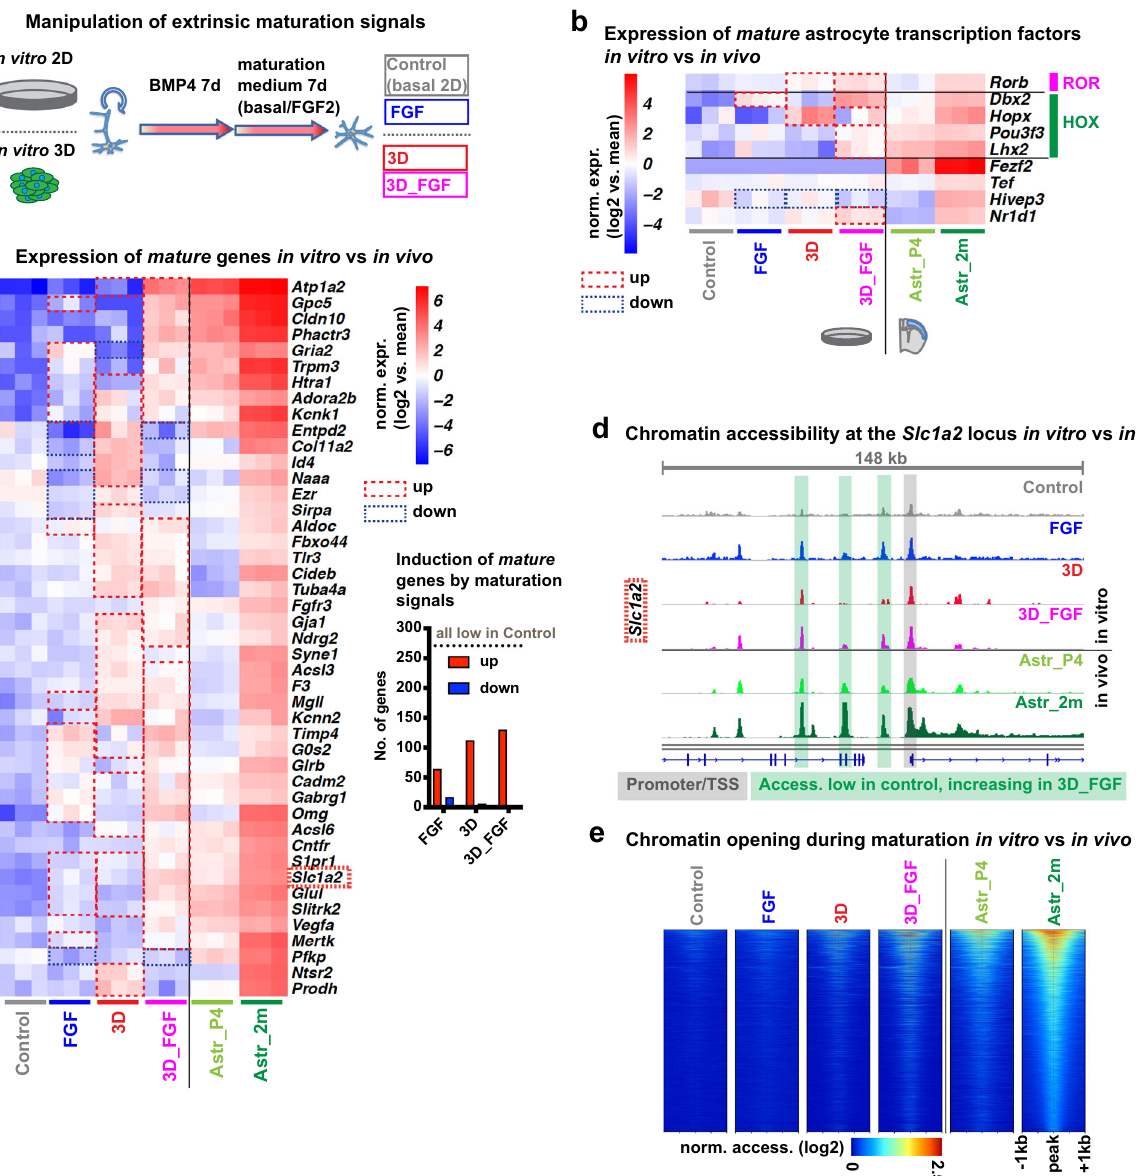
Fig. 7 Extrinsic signals promote the transcriptional and epigenetic maturation of astrocytes. a Experimental design to assess the effects of extrinsic signals on astrocyte maturation. Initial differentiation with BMP4 is followed by 7 days in different maturation conditions: control (basal medium in conventional two-dimensional cultures) ±FGF2 (control/FGF) or in three-dimensional gel-embedded cultures (3D/3D_FGF). b , c Expression of mature astrocyte-speci fi c transcription factors ( b ) and other genes ( c ) in cultured astrocytes and cortical astrocytes (at postnatal day 4 (Astr_P4), and 2 months of age (Astr_2m)). Heatmaps of selected genes. Barplot showing that subsets of mature genes with low expression in control cultures are induced in other culture conditions. d ATAC-Seq genome tracks showing chromatin accessibility peaks around the TSS of the mature astrocyte-speci fi c gene Slc1a2 , which is expressed at higher levels in astrocytes in 3D cultures in the presence of FGF2 than in astrocytes in control cultures (see ( c )). e Heatmaps showing global chromatin accessibility around ATAC peaks that are induced during maturation of cortical astrocytes and in astrocytes in 3D cultures with FGF2, but are absent in control cultures (5499 peaks). Statistical analysis and data presentation: Differential genes/peaks: DESeq2 analysis, each n = 3 ( n = 4 for Astr_2m); two-sided Wald test with Benjamini – Hochberg correction; signi fi cance threshold: adjusted p -value ≤ 0.05, absolute log2(fold change) ≥ 1. b , c Shown are log2-transformed mean centred, normalized expression values. d Tracks represent merged reads of 3 replicates (4 replicates for Astr_2m). e Heatmaps show normalised ATAC read count of merged samples in 20 bp windows ±1 kb of peak centres. Shown are log2-transformed normalized expression values. See also Supplementary Data